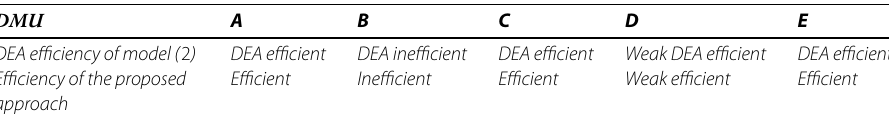
The same spanning production possibility sets of DMUs D and E are shown in Figure (c), the inequalities of DMUs D and E are expressed by () and () separately. The two line segments OD and OE meet on the production possibility set T D = T E at the production frontier, and there is only one solution for () and (), respectively. In addition, the data of Input  of DMUs D and A are equal, but the data of Input  of DMU D are